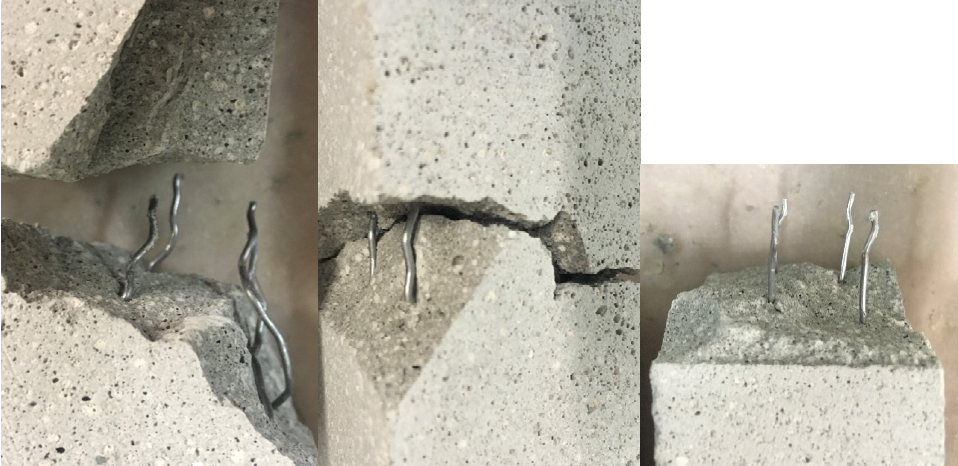
Figure 18. Fracture surface depending on the bond behavior.